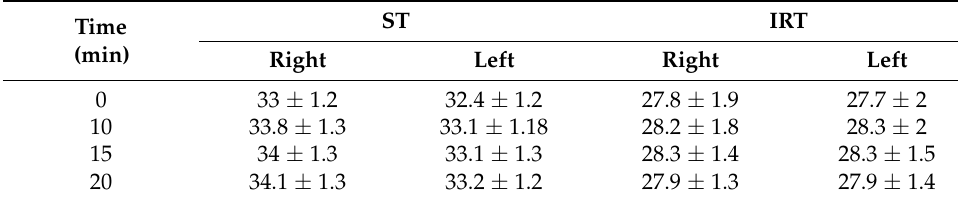
Table 4. Average temperature for each